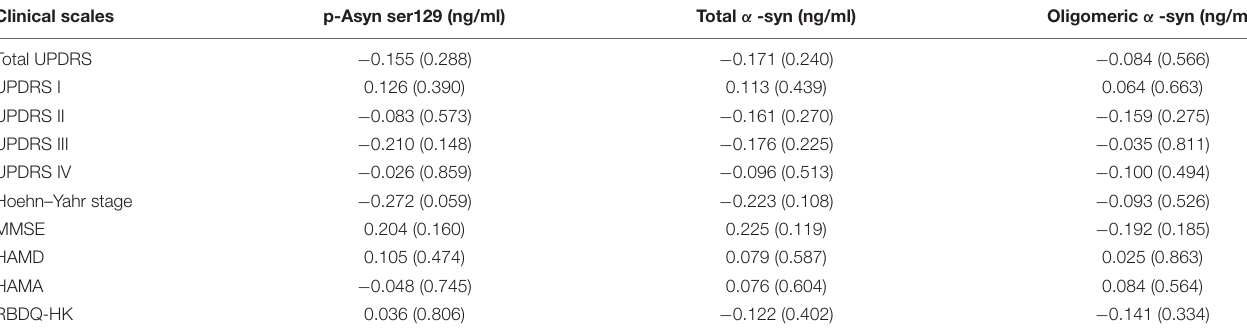
TABLE 3 | Partial correlation analysis between Lewy body-associated proteins levels and clinical characteristics scores. Clinical